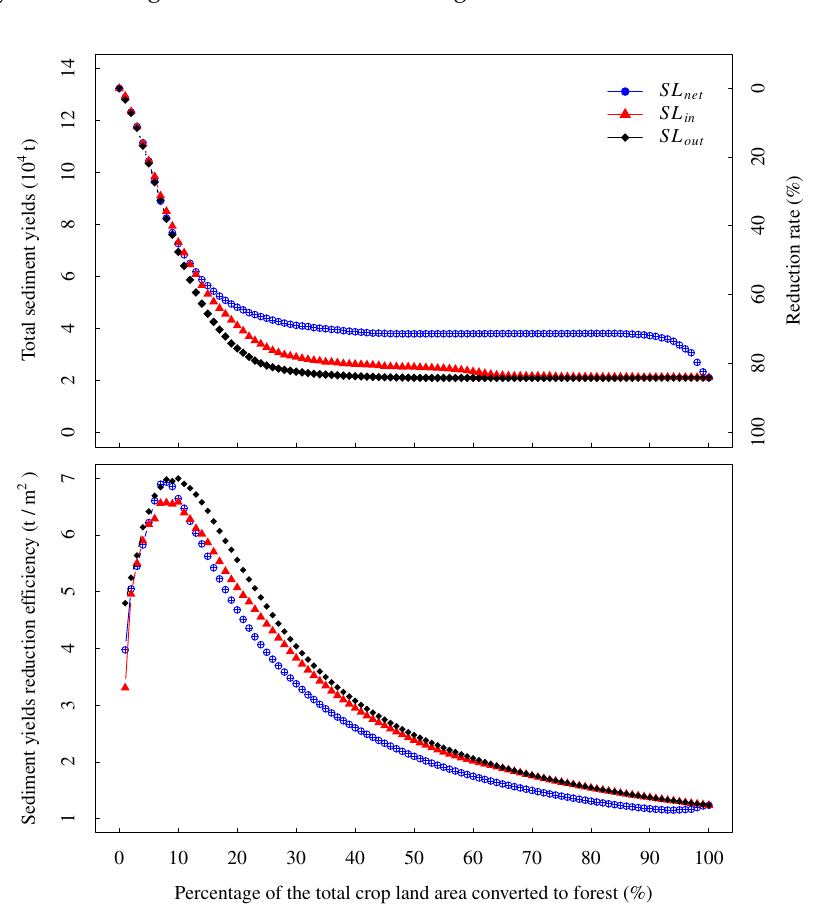
Figure 8. Total annual sediment yields entering the stream ( upper panel ) and sediment yield reduction efficiency per unit conversion area ( lower panel ) through changing bare soil and crop fields into forest sequentially from the area with the highest to the area with the lowest amount of net soil erosion ( SL net ), sediment inflow to the element ( SL in ), and sediment output from the element ( SL out